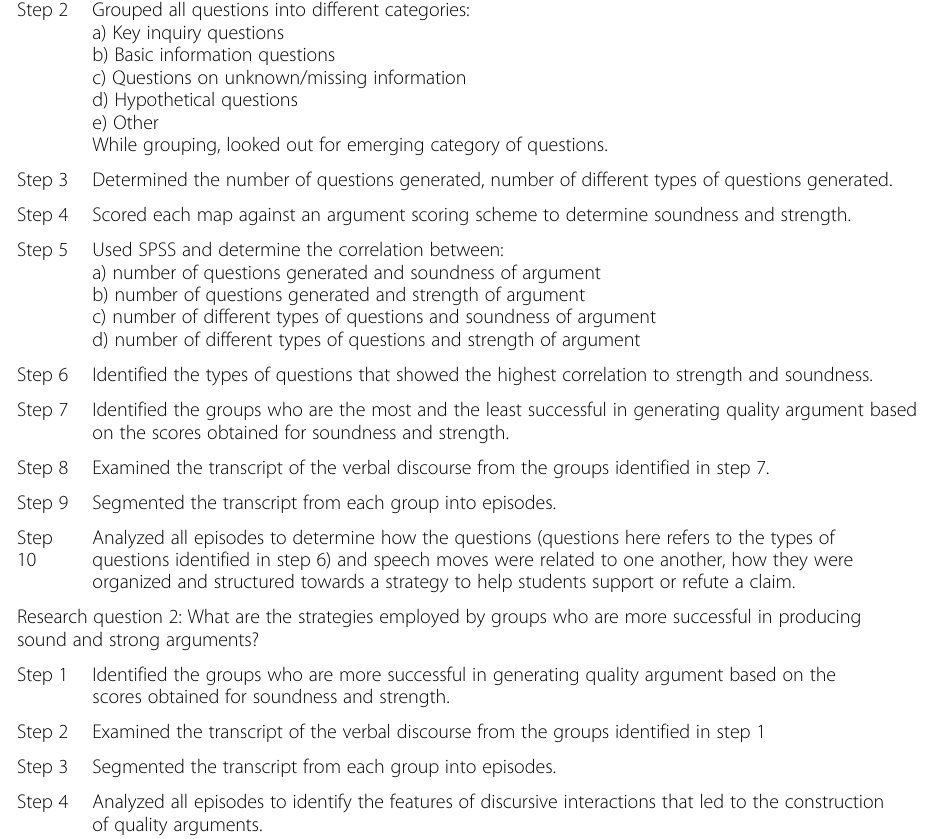
Table 2 A summary of data analysis for each research question Research question 1: What questions are generated by students during group discussions and how are these questions used in constructing productive arguments? Step 1 Identified all questions written artefacts and